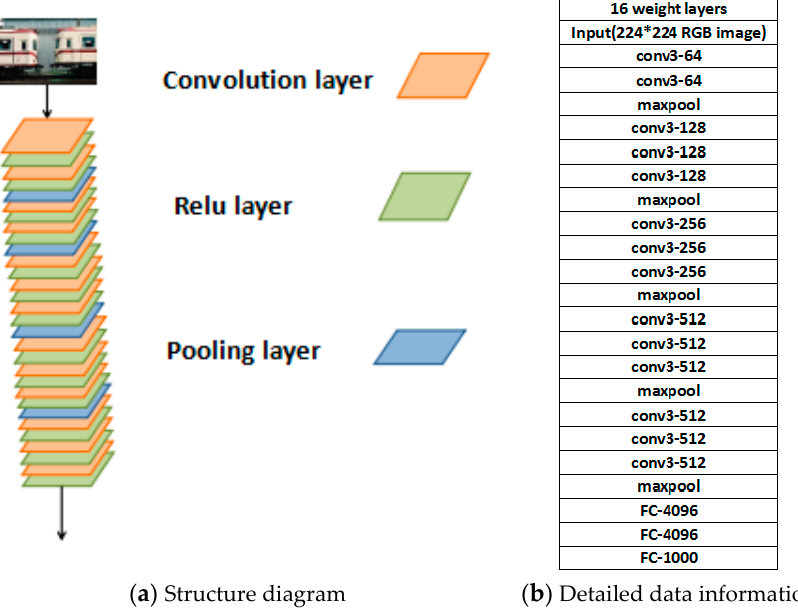
Figure 2. The architecture of VGG-16. ( a ) shows the structure diagram of the VGG-16 net; ( b ) shows the detailed data information of the VGG-16 net. In the convolution layers, there are 13 convolution layers, 13 relu (Rectified Liner Units) layers, and four pooling layers. In all convolution layers, the convolution kernel is 3 × 3 and stride is 1. In the Faster R-CNN, the size of the image becomes (m + 2)(n + 2) because all convolution features are padded (pad = 1). The advantage of this is that the output image’s size is the same as the input. The convolution formula is given